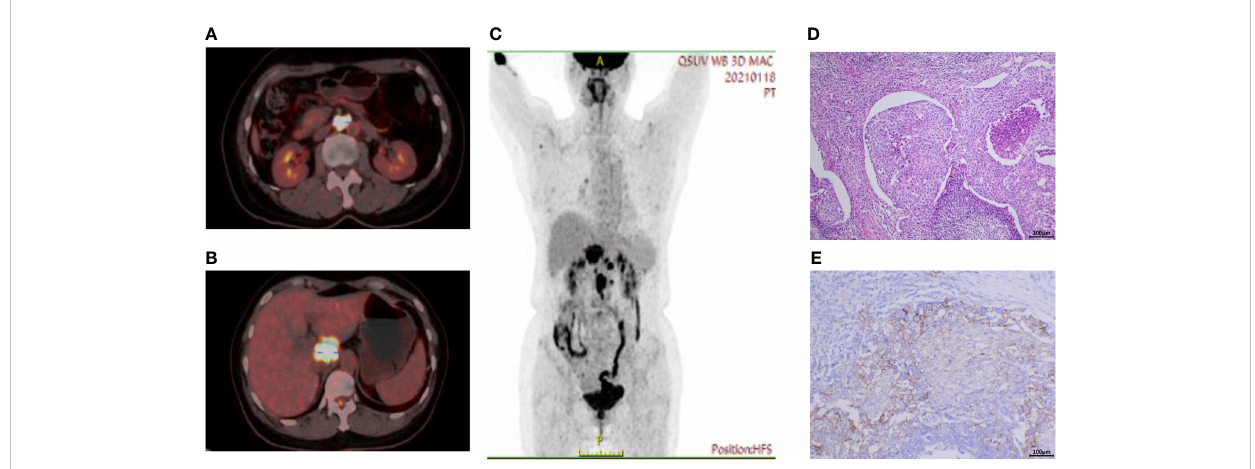
FIGURE 1 Baseline PET-CT imaging and pathologic results. (A) High uptake of fl uorodeoxyglucose (FDG) in enlarged retroperitoneal lymph nodes and (B) peripancreatic lesions below the caudate lobe of the liver. (C) Coronal view showed multiple hypermetabolic lesions in the abdominal cavity. (D) Hematoxylin and eosin staining on hepatopancreatic lesions under endoscopic ultrasound showed poorly differentiated carcinoma. (E) The Dako PD-L1 22C3 assay immunohistochemistry assay for PD-L1 expression revealed that the tumor proportion score (TPS) was 35%. Scale bar = 100 m